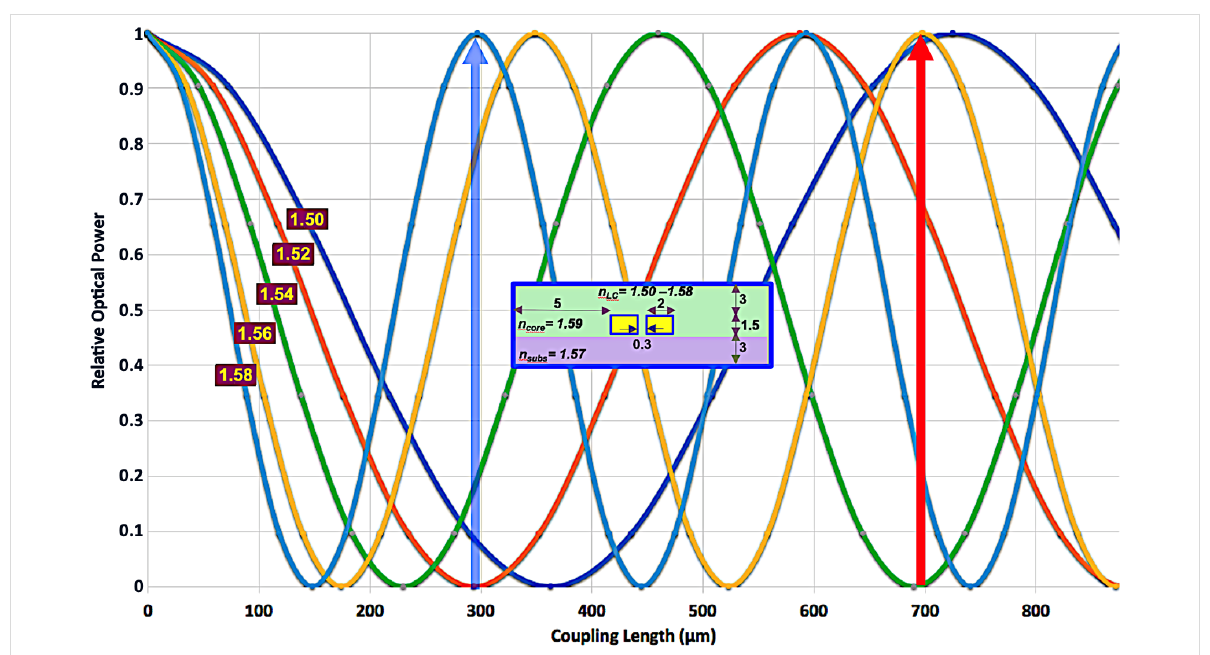
Figure 2: Power output in the input waveguide as a function of the effective refractive index of the LC cladding. The modeled directional coupler dimensions (in µm) and refractive indices are shown in the inset. The wavelength is 632.8 nm. The arrows show two examples of optical switches that could be obtained from this structure.